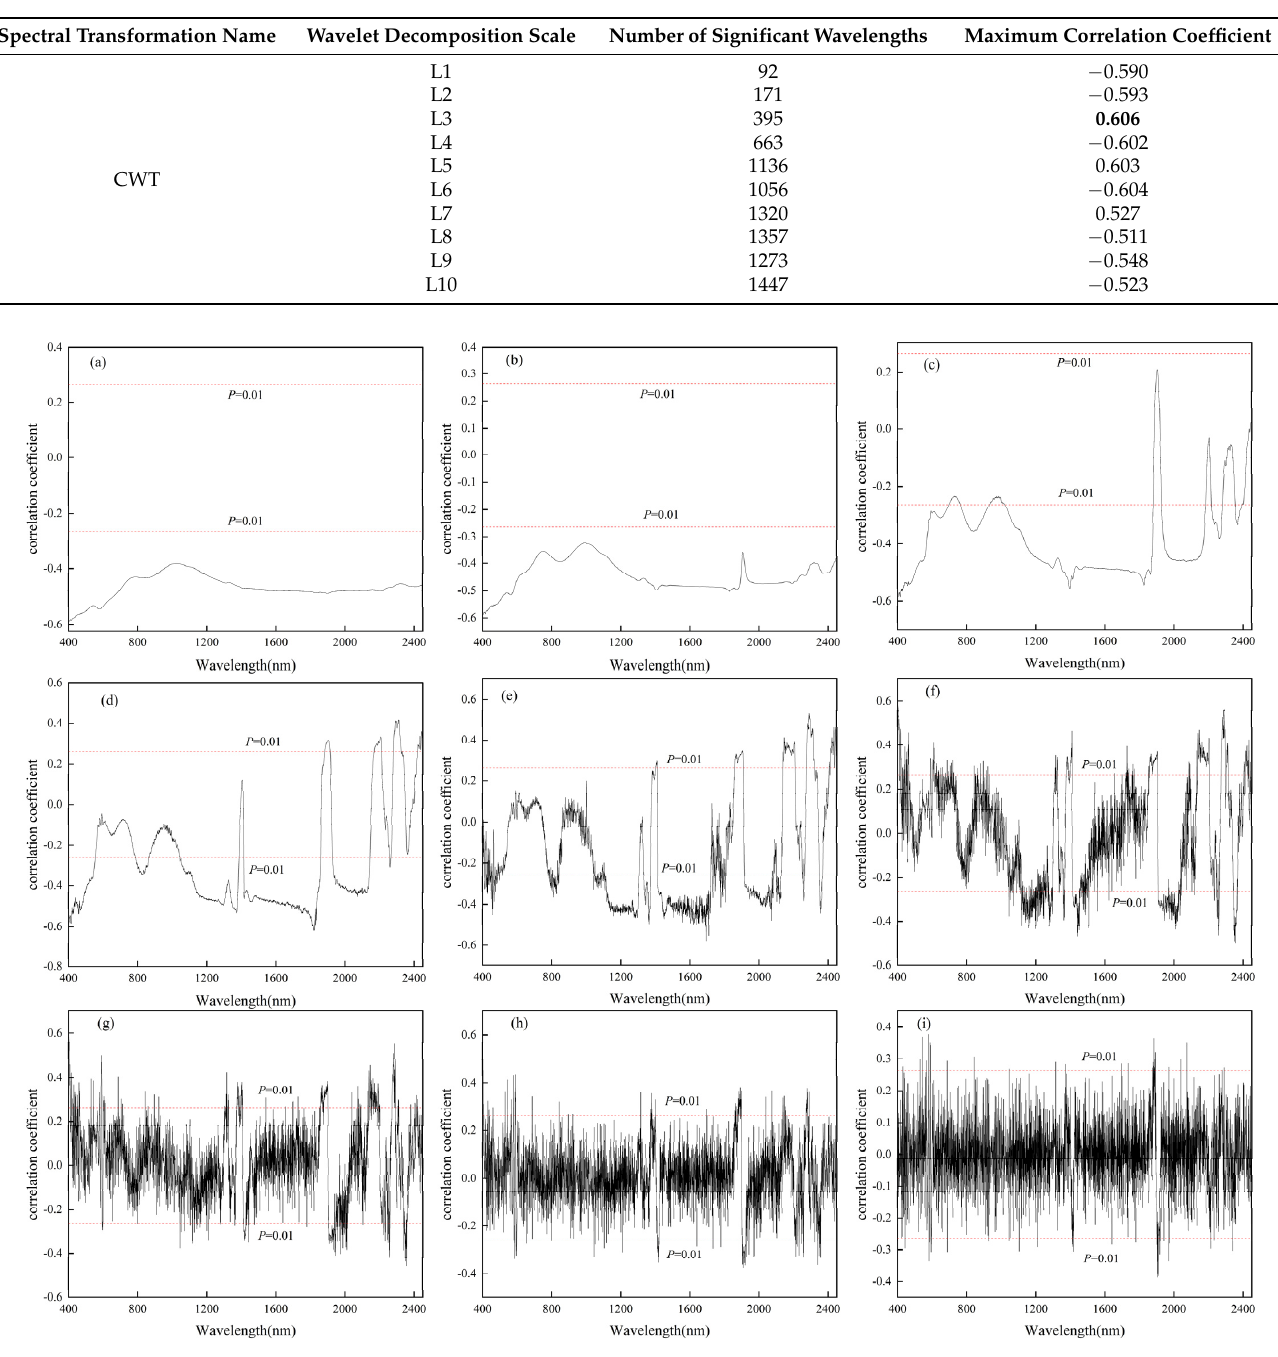
Table 3. The number of wavelengths passing the significance test ( p < 0.01) and the maximum correlation coefficient for different scale in CWT.